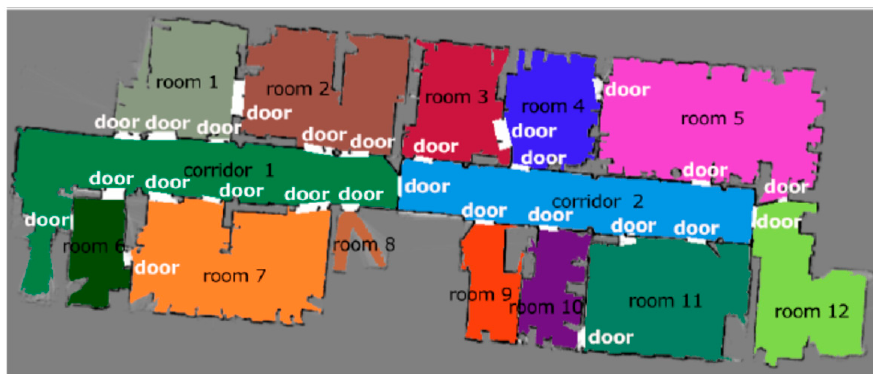
Figure 1. Object-based semantic map.